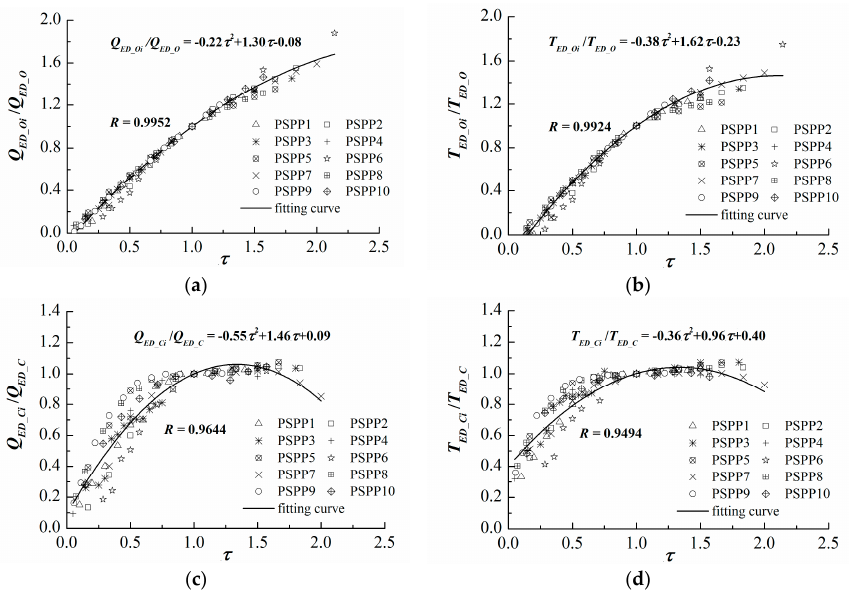
Figure 4. The relationship between τ and the relative characteristic parameters of O i and C i : ( a ) τ − Q ED _ Oi / Q ED _ O ; ( b ) τ − T ED _ Oi / T ED _ O ; ( c ) τ − Q ED _ Ci / Q ED _ C ; ( d ) τ − T ED _ Ci / T ED _ C .